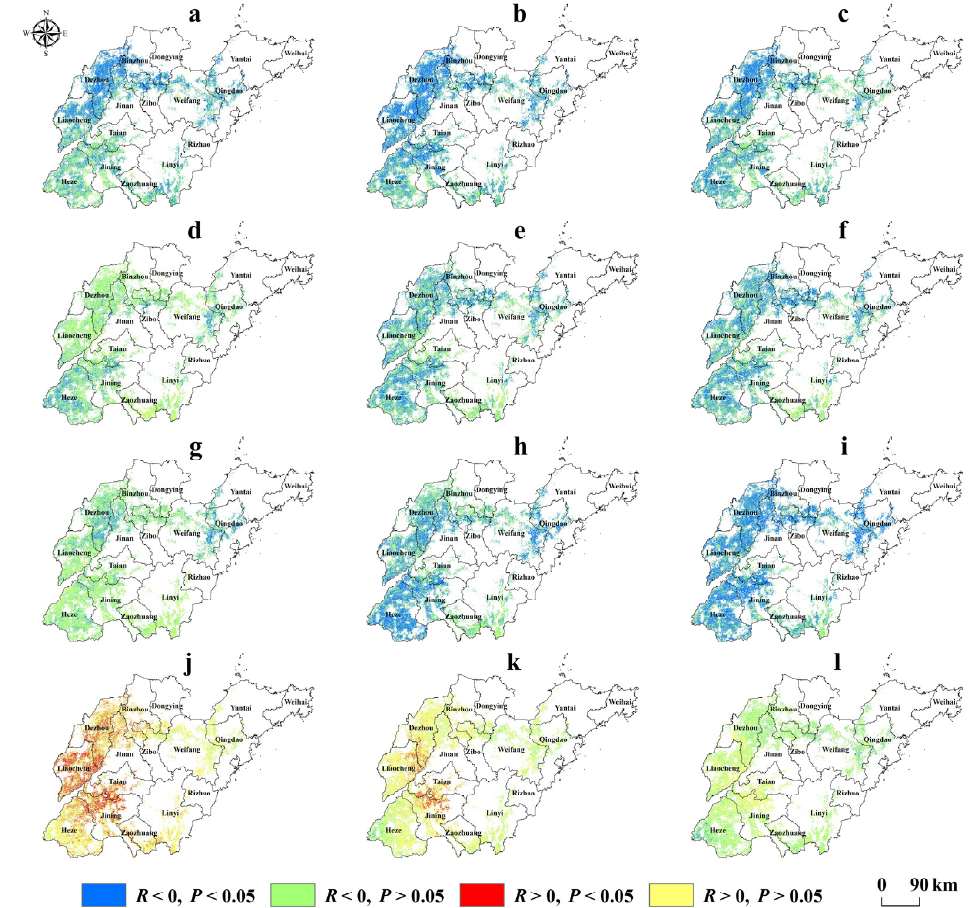
Figure 9. Spatial pattern of the Pearson’s correlation coefficient between the key winter wheat phenological stages and mean temperature in preseason. ( a – c ), respectively, refer to correlations of green-up date with T mean1 , T mean2 , and T mean3 ; ( d – f ) represent the correlations of jointing date with T mean1 , T mean2 , and T mean3 , respectively; ( g – i ) are correlations of heading date with T mean1 , T mean2 , and T mean3 , respectively; and ( j – l ) are correlations of maturity date with T mean1 , T mean2 , and T mean3 ,